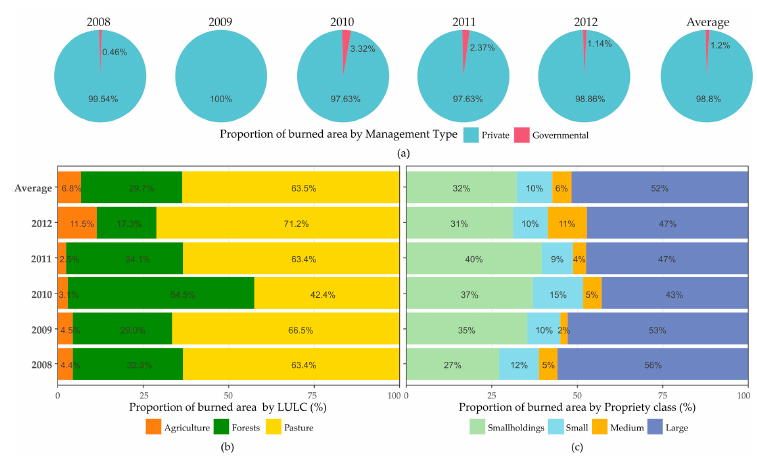
Figure 4. The proportion of burned area by ( a ) management types; ( b ) land use and land cover; ( c ) propriety